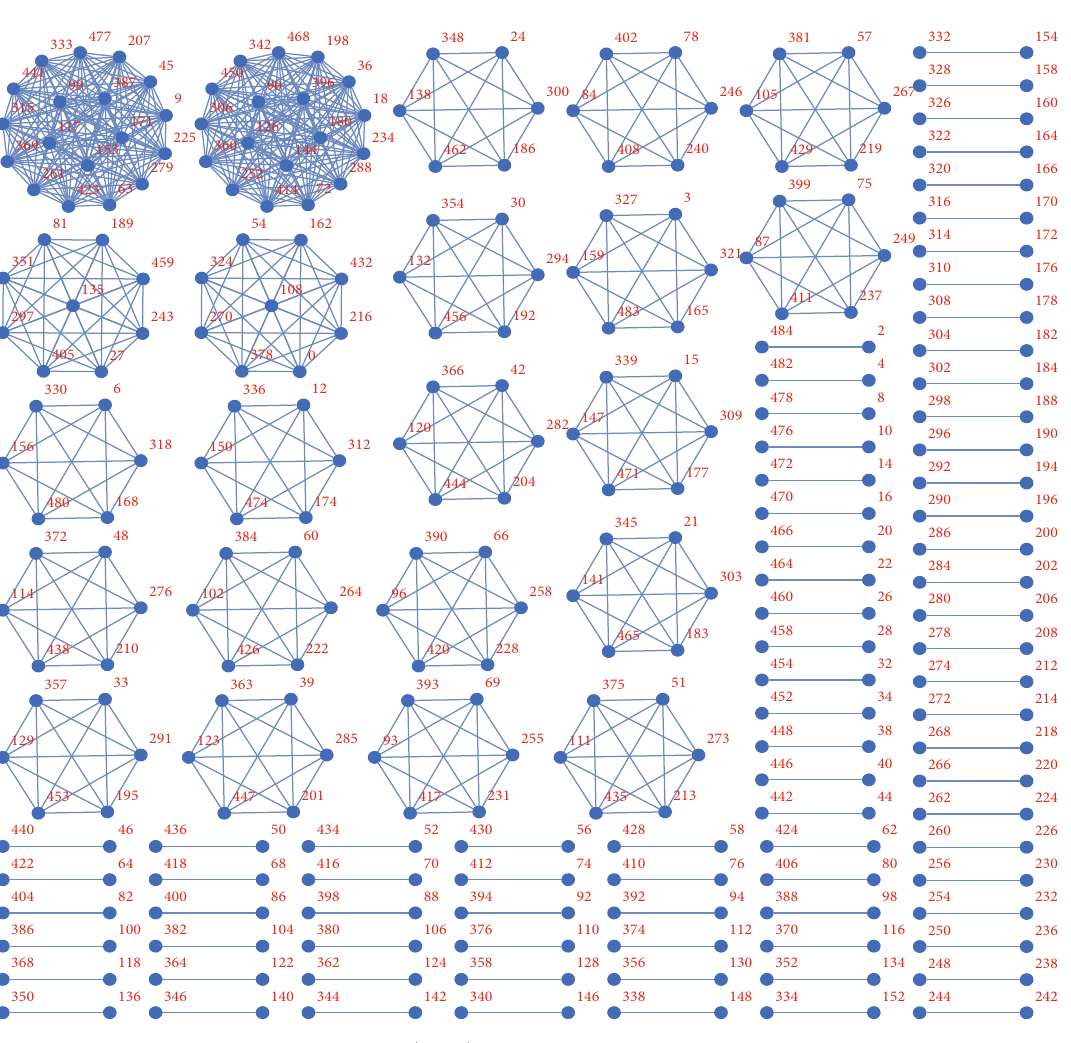
Figure 5: G ð 2,486 Þ = 81 K